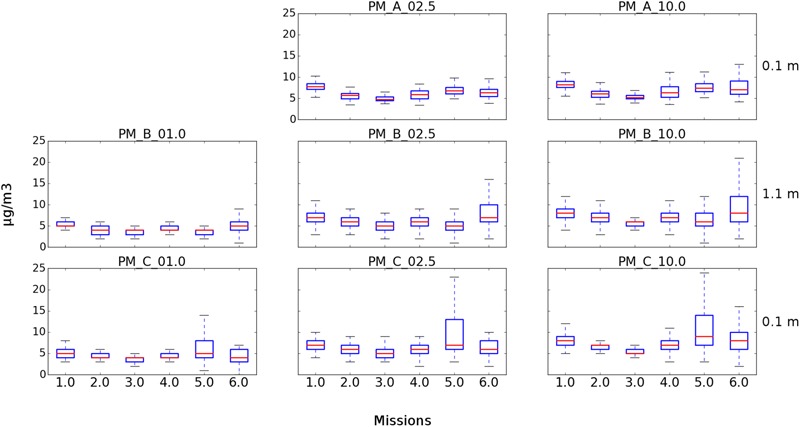
Box plots showing PM concentrations from USV missions at Great Pond, Falmouth, MA, United States. Three of the four integrated particle sensors were operational for the six missions. (Top) Represents the SDS021 sensor at 0.1 m for PM2.5 and PM10. (Middle) Represents the PM7003 sensor at 1.1 m for PM1, PM2.5, and PM10. (Bottom) Represents the PM7003 sensor at 0.1 m for PM1, PM2.5, and PM10.